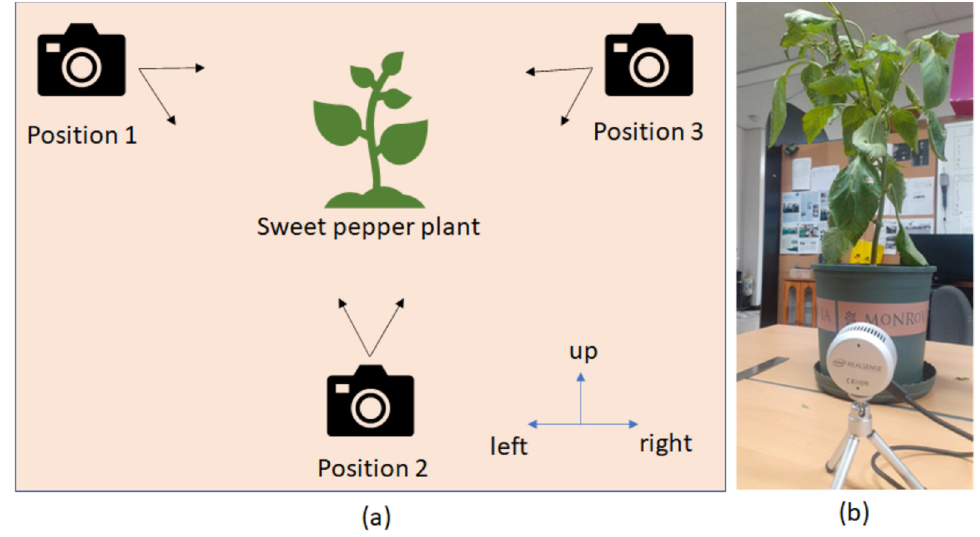
Figure 10. Setting up the experiments. ( a ) shows camera positions, and ( b ) is a camera position example of experiments. The black arrows are camera viewpoints. The blue arrows are moving camera directions.